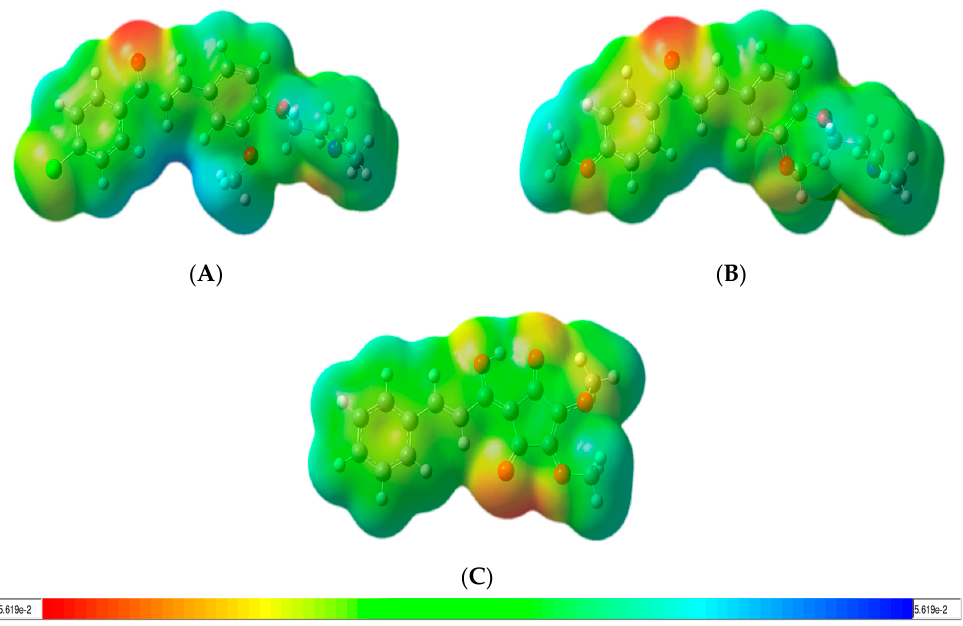
Figure 5. Molecular electrostatic potential maps for compounds 4a ( A ); 4d ( B ) and linderone ( C ).